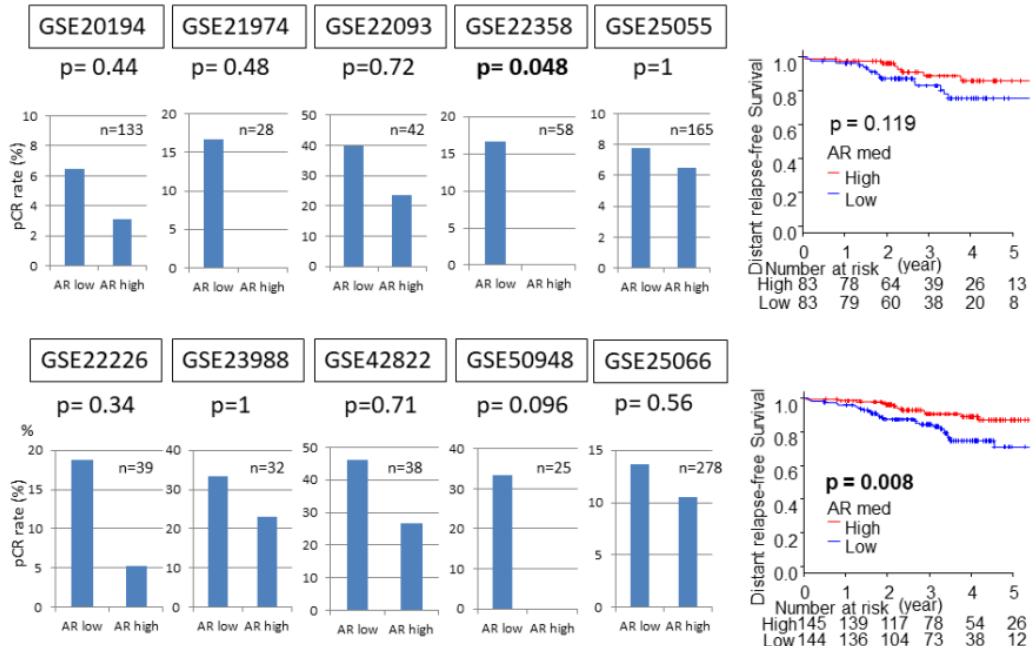
Figure 6. pCR rate and Kaplan–Meier survival curve by AR mRNA levels of GEO cohorts. High and low expressions are represented by the red and blue lines, respectively.